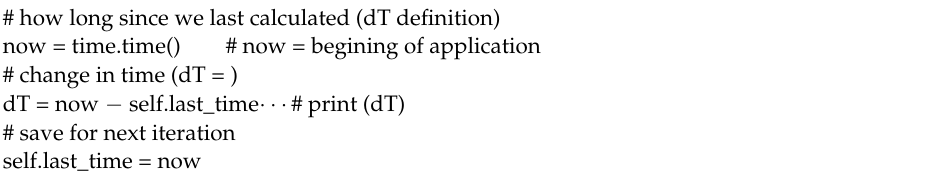
Algorithm 5. Fragment of the Python code: time variable dT definition.